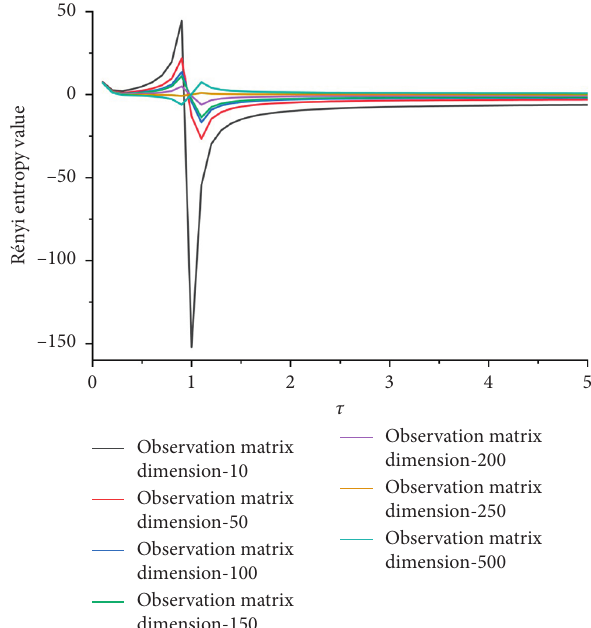
Figure 8: Transformation trend of R´enyi entropy with parameter